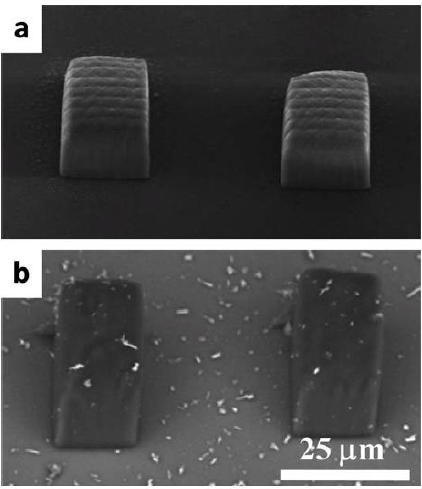
Figure 5. SEM images of two-photon polymerized ZnO nanowires/polymer composite microstructures containing 0.5 ( a ) and 1.0 ( b ) wt % of ZnO nanowires. Reprinted with permission from [65]. Copyright (2014) Wiley Online Library.